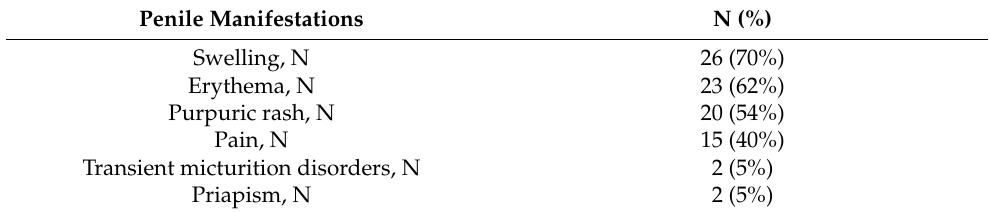
Table 3. Symptoms and clinical findings of penile involvement in 37 Henoch–Schönlein patients.